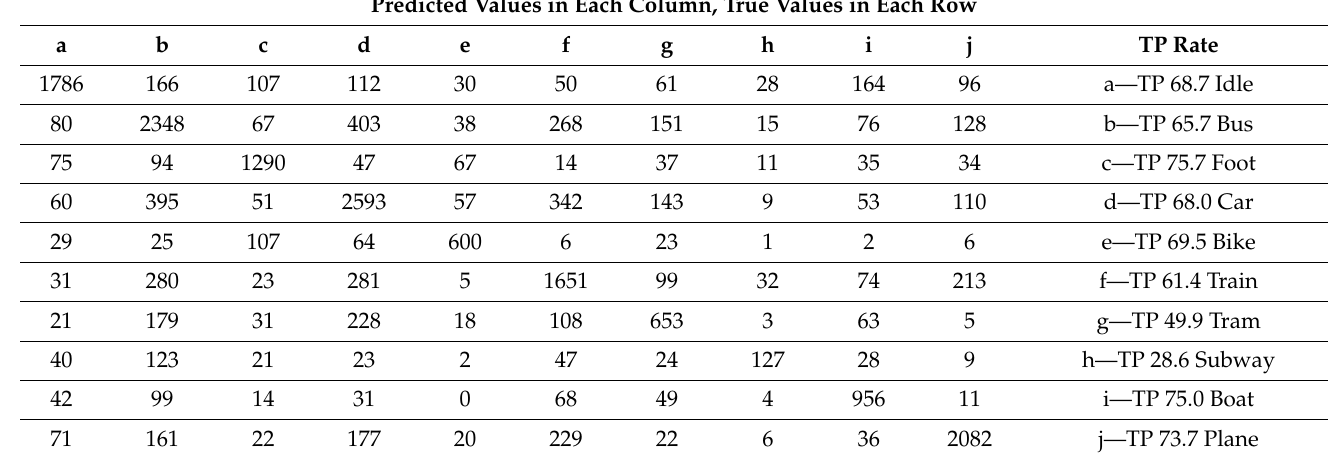
Table 5. Confusion matrix for the classes (10-fold, RF).